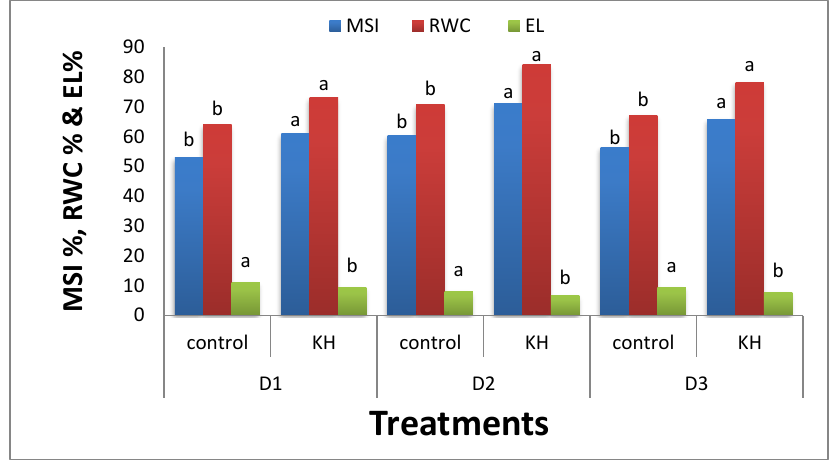
Figure 4. Effect of potassium humate (KH) application and planting density treatment on membrane stability index (MSI%), relative water content (RWC%) and electrolyte leakage (EL%) of Vicia faba L. plants. For each parameter, treatments followed by the same letter are not significantly different at p ≤ 0.05.